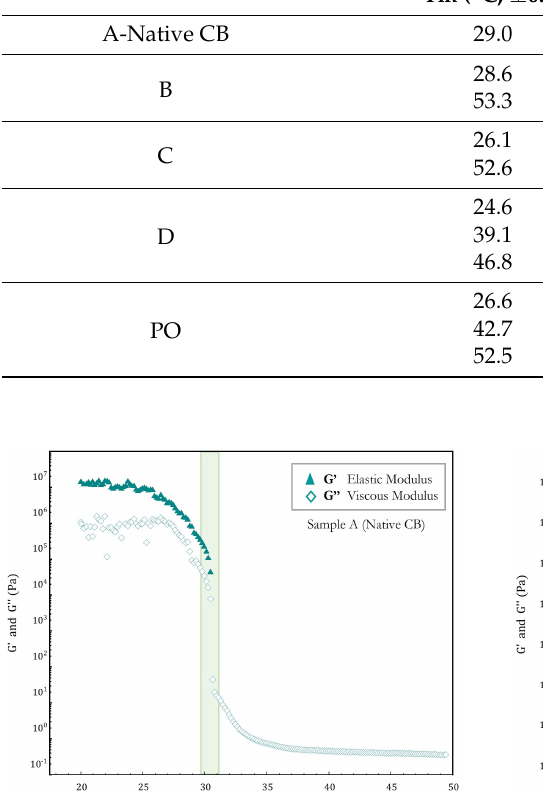
Table 1. Temperature of melting ((T m , ◦ C) and melting enthalpies ( ∆ H m , J/g) of native CB (sample A), modified samples B, C and D, and palm oil (PO) determined via DSC (Differential Scanning Calorimetry). Instrumental errors have been reported for both temperature and enthalpy values. Tm ( ◦ C, ± 0.1) ∆ Hm (J/g, ± 0.1)